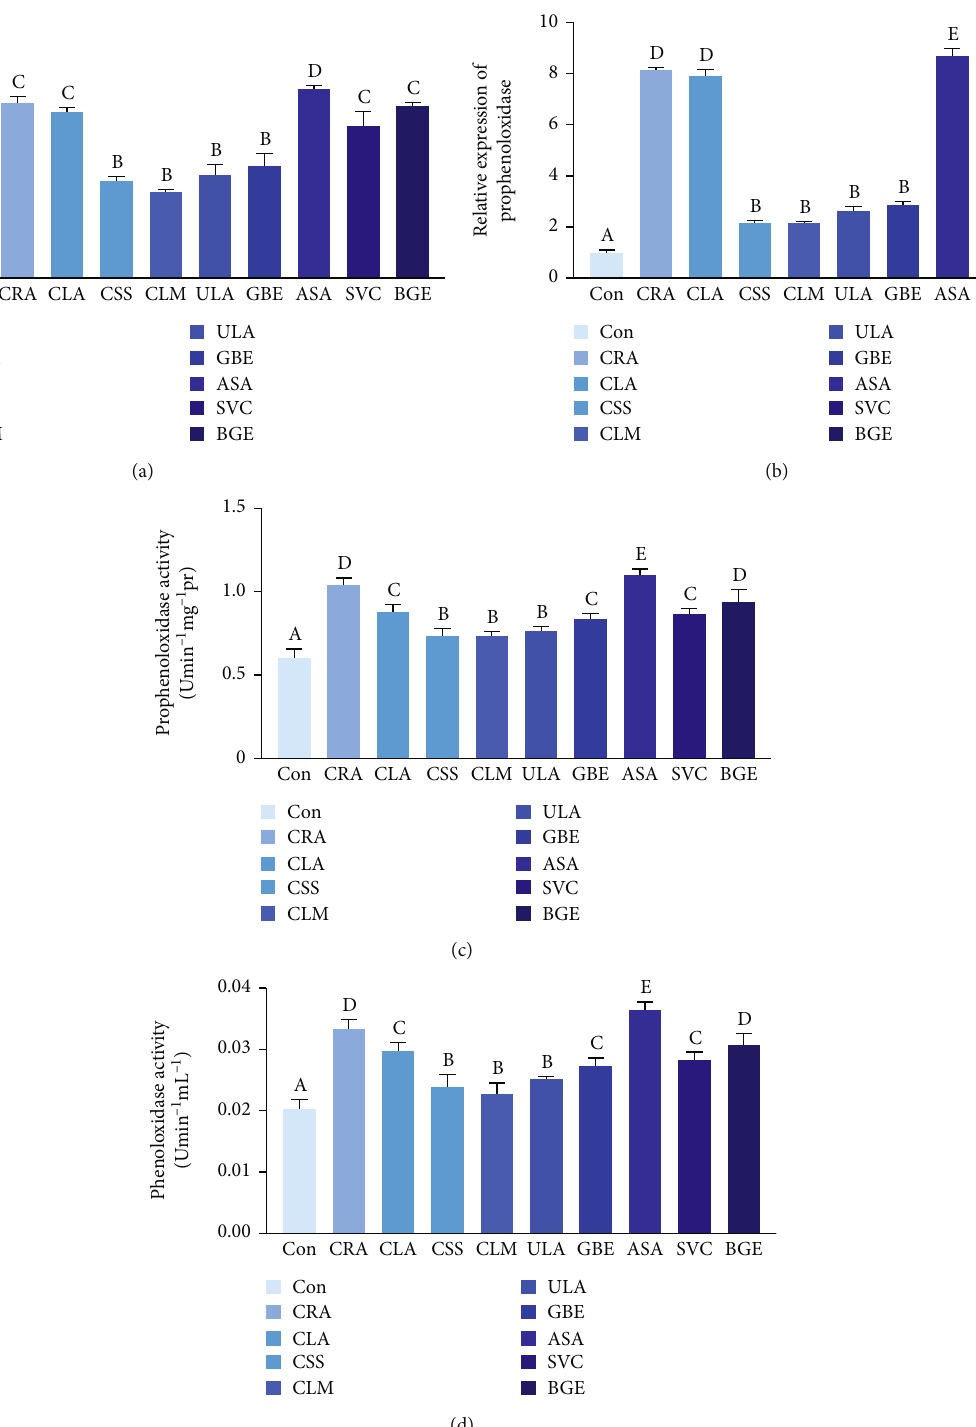
Figure 2: E ff ects of macroalgae diet on the proPO system of L. vannamei . Relative expression of prophenoloxidase-activating enzyme (a), relative expression of prophenoloxidase (b), prophenoloxidase activity (c), and phenol oxidase activity (d) of L. vannamei in di ff erent groups. All data were expressed as mean ± SE ( n = 3 ). The mean column of di ff erent superscript letters (A – E) was signi fi cantly di ff erent ( P < 0 : 05